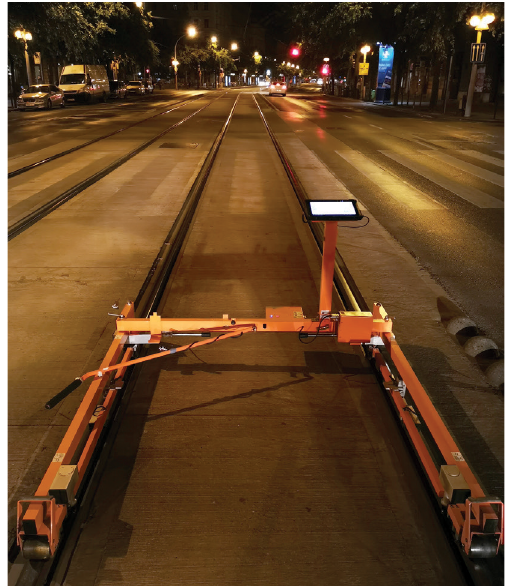
Figure 1. TrackScan 4.01 instrument (authors’